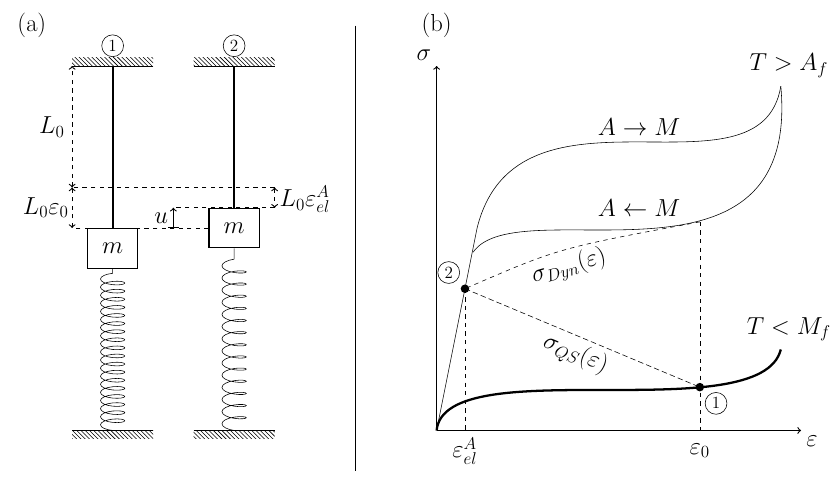
Figure 2. Schematics of an SMA actuator in a spring-mass configuration. ( a ) The SMA wire is connected to a mass and spring at its free-end. In 1 (cid:13) , the wire is completely in its detwinned martensitic phase with a strain of ε 0 relative to its original length in the austenite phase. In 2 (cid:13) , the wire is completely in its austenite phase with an elastic strain of ε A . ( b ) Diagram of austenite- el martensite transformations in the stress-strain space. The upper flag diagram (thin solid lines) is the superelastic transformation path at temperatures above A f . The lower curve (bold solid line) is the detwinning path at temperatures below M f , Points 1 (cid:13) and 2 (cid:13) correspond with the diagrams in ( a ). The dashed lines denoted by σ QS ( ε ) and σ Dyn ( ε ) are the shape-memory transformation paths under quasi-steady and rapid heating,